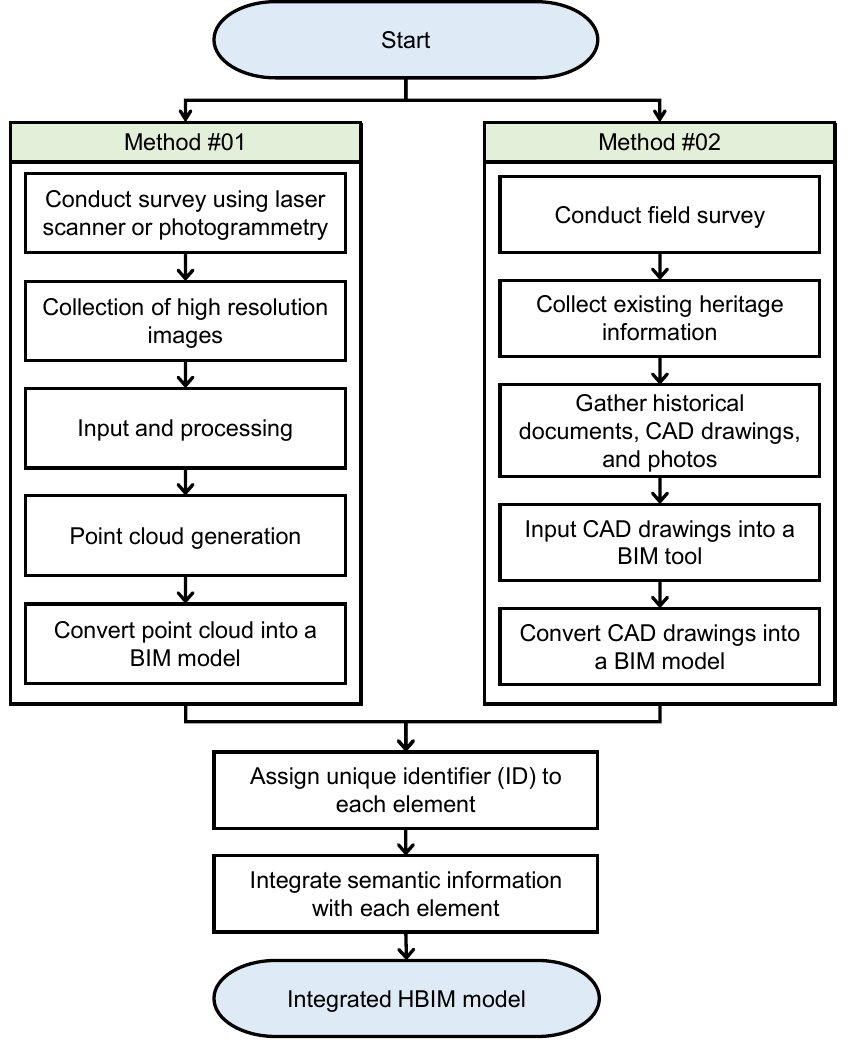
Figure 4. The process of developing an HBIM model.